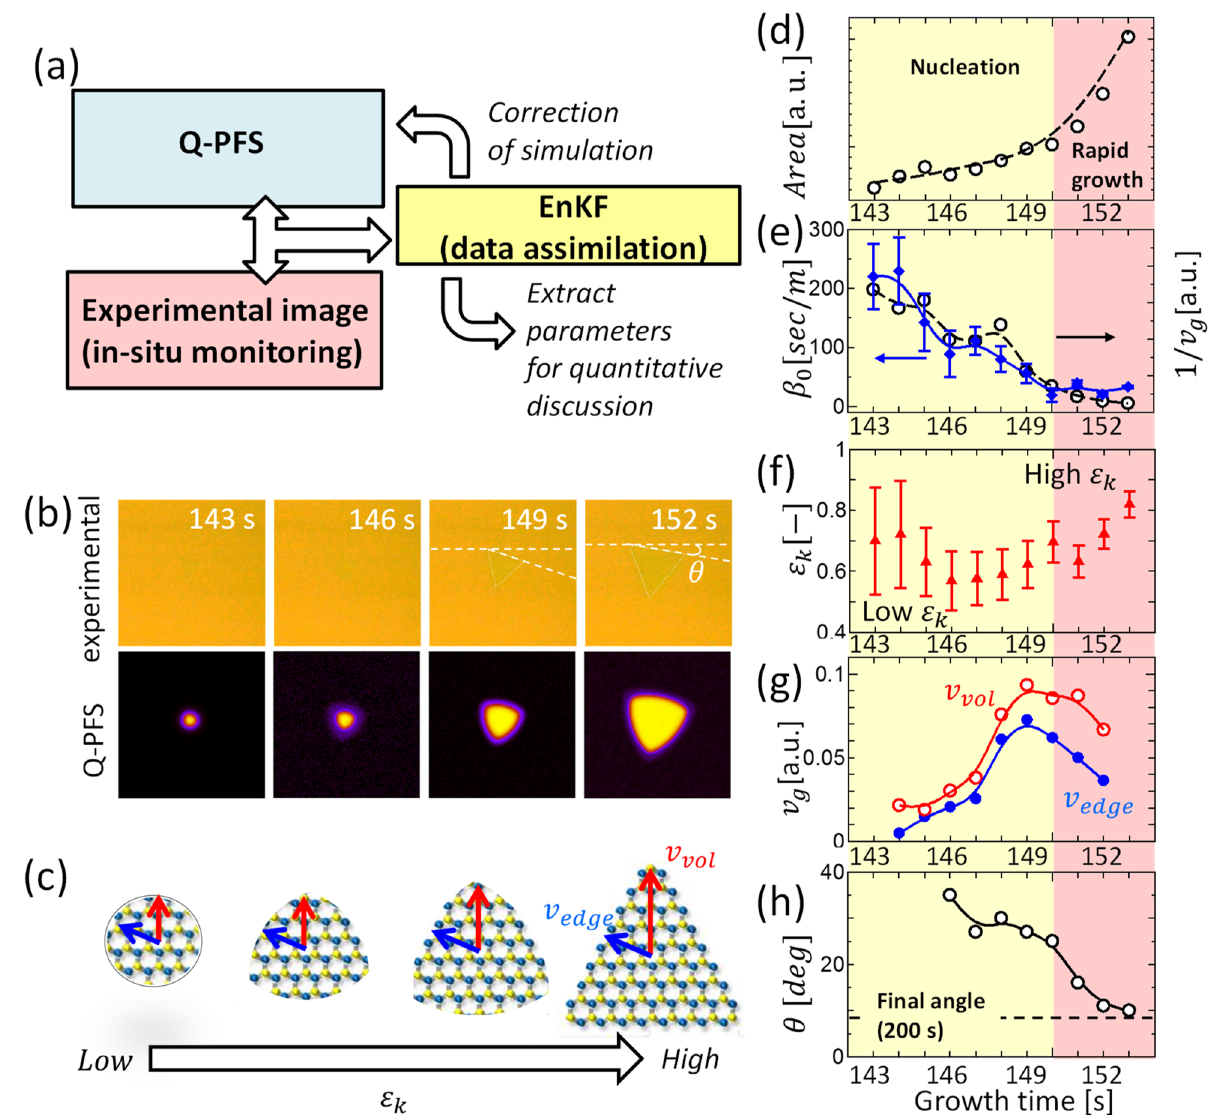
Figure 4. Data assimilation of Q-PFS and in-situ images. ( a ) Schematic of calculation flow. ( b ) Typical results of (up) experimental and (down) calculated images for monolayer WS 2 growth. ( c ) Schematic of time evolution for the nucleation of WS 2 under the different ε k . ( d – h ) Plot of time evolution for ( d ) monolayer area (experiment), ( e ) 1 /β 0 (calculation) and v g (experiment), ( f ) ε k (calculation), ( g ) v edge and v vol (calculation), ( h ) θ circle-like shapes show high and low ε k , respectively (Fig. 4c). Because it is very difficult to qualitatively discuss the anisotropy of TMD from experimental data, using data assimilation to obtain ε k is useful for understanding the growth dynamics. When we plot the time evolution of ε k , it is seen that ε k has a relatively low value during the nucleation phase (144–148 s) (Fig. 4f). Then, the anisotropy gradually increases at almost the same time as the start of the rapid growth (Fig. 4f). This two-step change of ε k , revealed by the data assimilation approach, may also be correlated with the two-step nucleation, as shown in Figs. 2 and 3. The ε